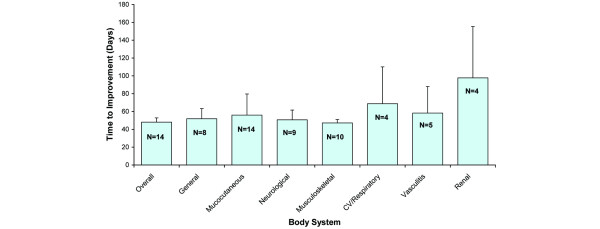
Mean time to improvement of each BILAG body stystem. Mean time to improvement (in days) of each BILAG body system during the follow-up of the study (N denotes the number of patients available for analysis for each body system). Since the first evaluation was scheduled for 6 weeks, the earliest time to improvement is at least 42 days.